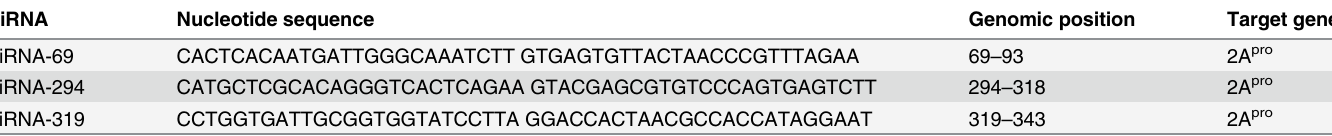
Table 1. Sequences of the synthesized siRNA molecules and their positions in the EV71 2A pro genomic region.